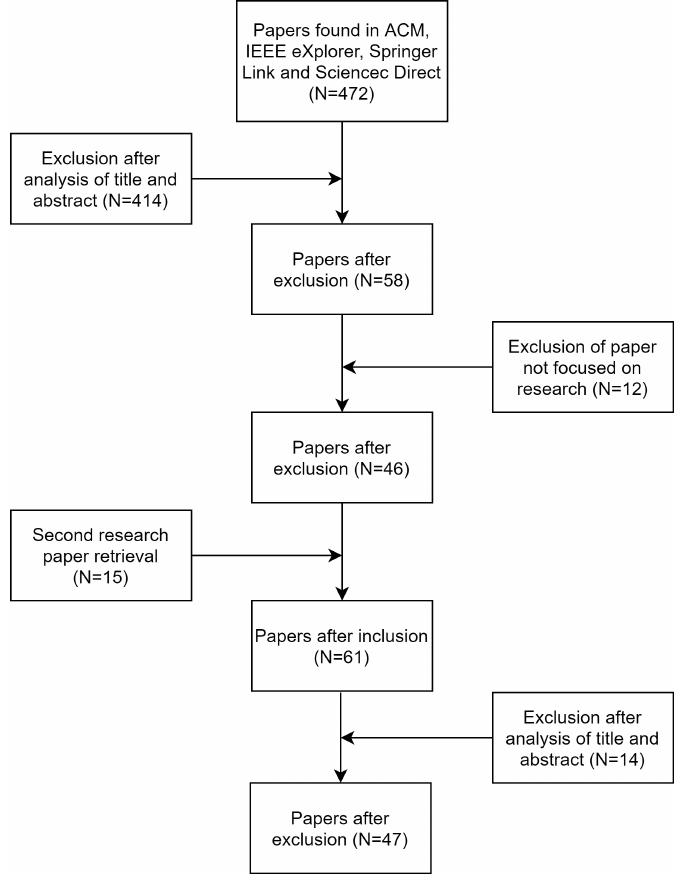
Figure 2. Paper reduction